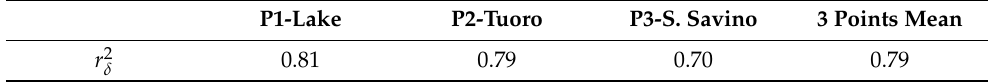
Figure 7. Correlation analysis between the monthly variations of the lake level, ∆ H , and water storage, δ , for the three ERA5L points closest to the lake: ( a ) P1-Lake, ( b ) P2-Tuoro, ( c ) P3-S. Savino, and ( d ) their weighted average. , between ∆ H and δ in the period Table 3. Pearson correlation coefficient, r 2 δ